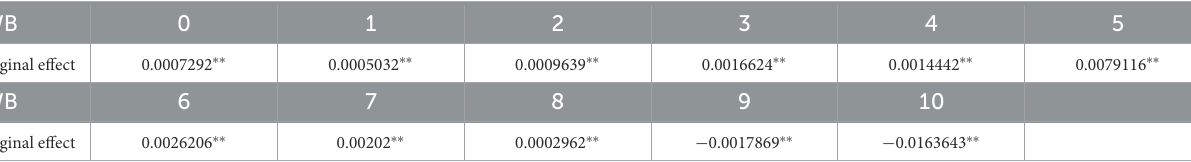
TABLE 3 Marginal effects of core explanatory variables.